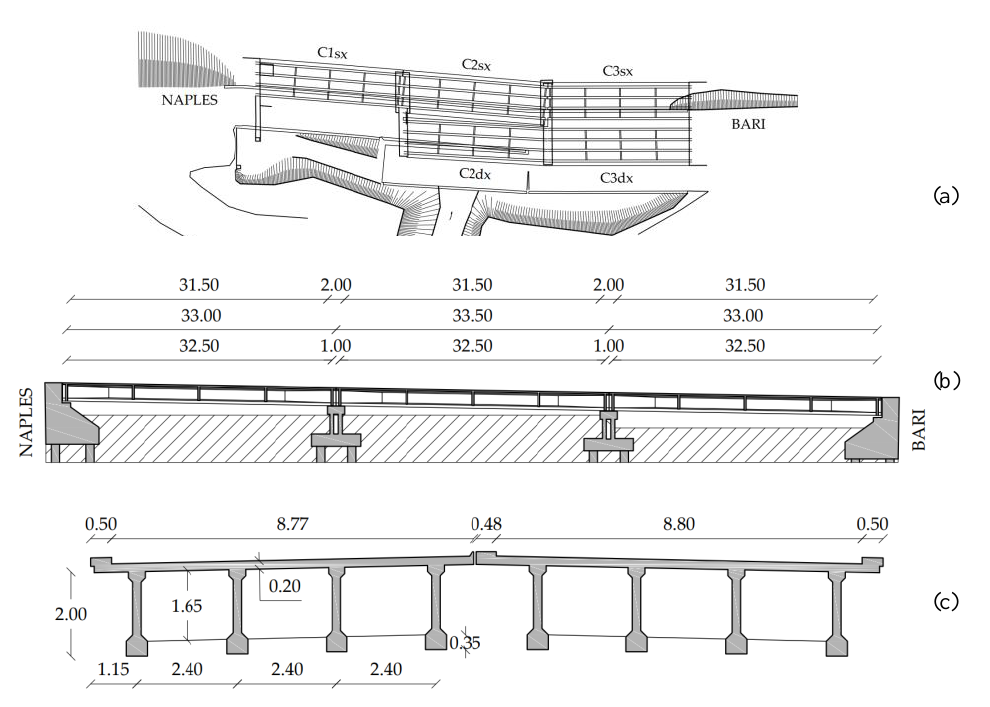
Figure 5. ( a ) Top view; ( b ) lateral view; and ( c ) cross section of the Alveo Vecchio viaduct (Italy).